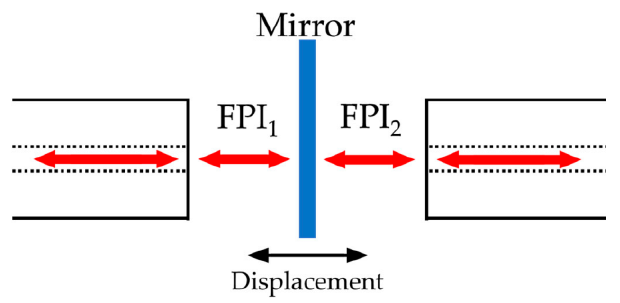
Figure 1. Sensor architecture